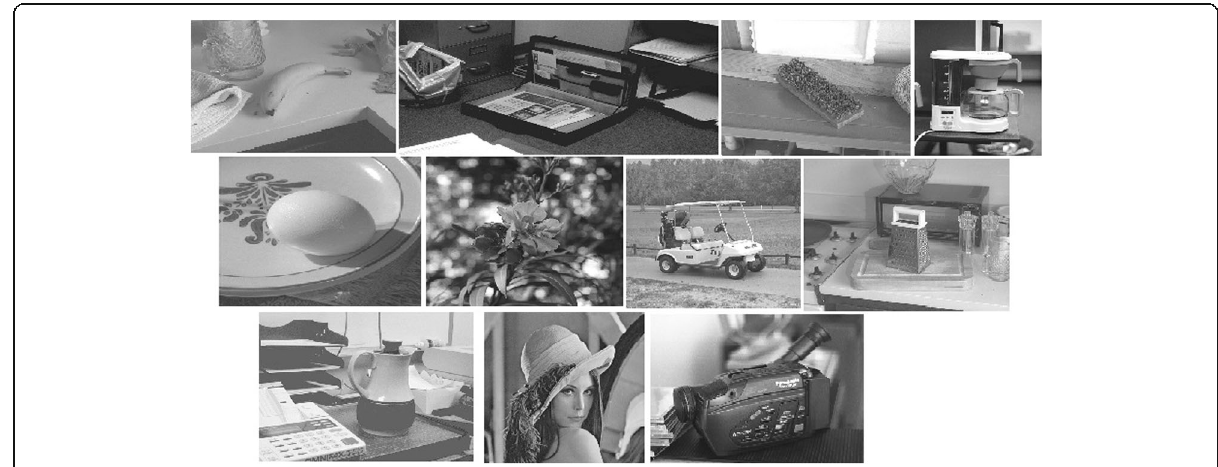
Fig. 6 Test images used for performance